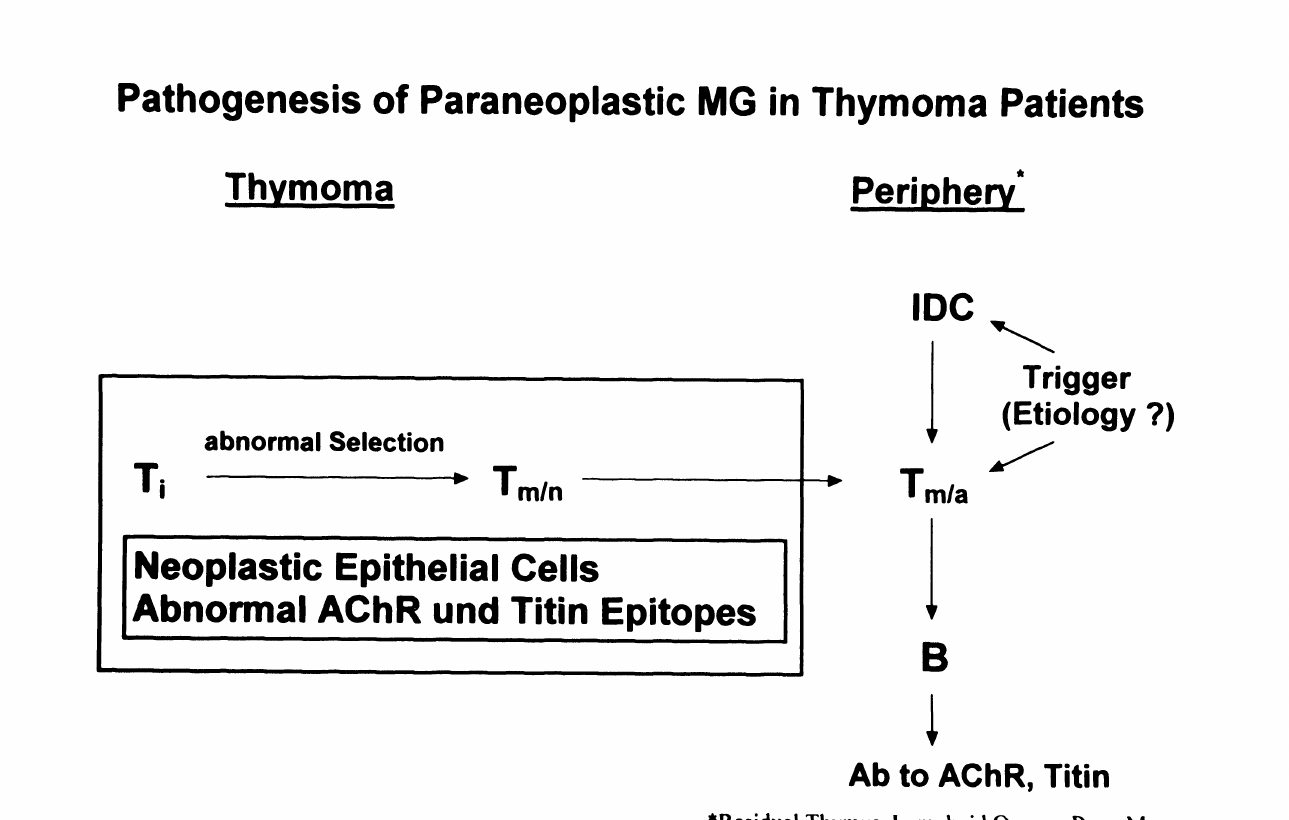
FIGURE 5 Pathogenesis of paraneoplastic MG in thymoma patients. According to this "two-step model," abnormal AChR and titin epitopes provide the molecular basis for an abnormal intratumorous selection that turns immature T cells (Ti) into mature and native T cells (Tnvn). In a second step, these AChR and titin-specific T cells are thought to leave the thymus and become actived T cells (Ta) only outside the tumor. The etiology-triggering T-cell activation is unknown (Vincent,